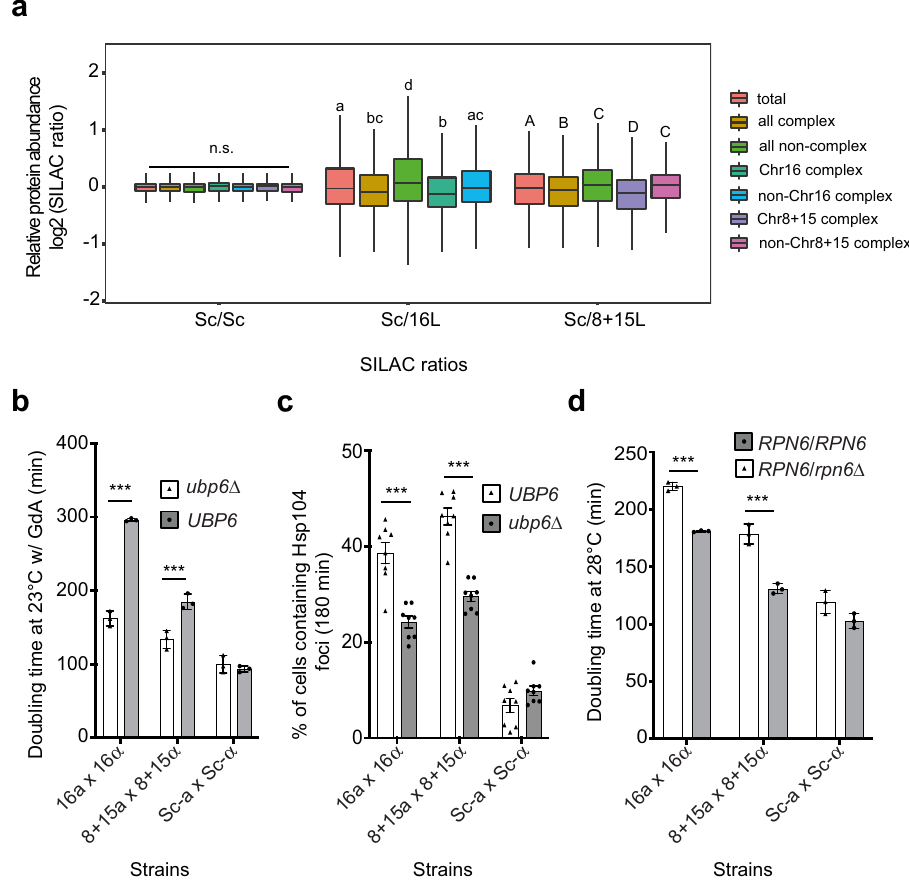
Fig. 4 | Proteotoxic stress in the replacement lines can be partially relieved by up-regulating the protein degradation machinery. a , Protein abundances of complexes having subunits encoded on Chromosome 16 are signi fi cantly reduced in 16L cells and Chromosomes 8+15 are reduced in 8+15L cells when compared to non-Chr16/non-Chr8+15 complexes, respectively (also see Supplementary Fig. 7). The distributions of log2-transformed SILAC ratios of proteins in different groups are shown in boxplots. Distributions with the same letter (above each boxplot) are not signi fi cantly different from each other (Dunn ’ s pairwise tests with Bonferroni correction, p >0.05, see Supplementary Data 11 for the p -values of all Dunn ’ s pairwise tests).n.s.: not signi fi cant. b Growth defects of the 16L and 8+15Llines are partially rescued by deleting the UBP6 gene. The ubp6 Δ mutants exhibit enhanced proteasomal degradation activity, thereby facilitating the removal of destabilized complex subunits. Diploid cell lines were grown in YPD with 50 μ M Geldanamycin